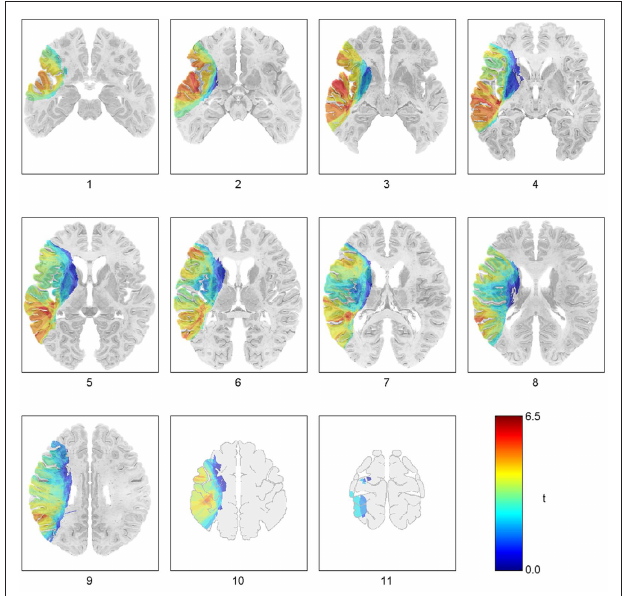
Figure 1 | Voxel-based lesion-symptom mapping findings for the regions critical for auditory sentence comprehension, as assessed by the CYCLe-r. The t -map is visualized on 11 slices from the DeArmond et al. (1989) brain atlas, which was used as the template for lesion reconstructions. Significant voxels from this map comprised five distinct regions, each associated with a different pattern of performance (see text). (Reprinted with permission from Dronkers et al., 2004).